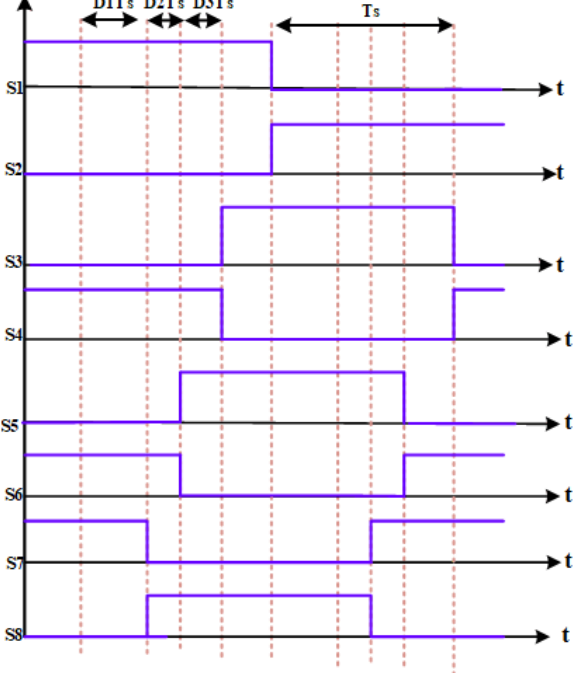
Figure 17. Triple-Phase Shift control switching pattern.